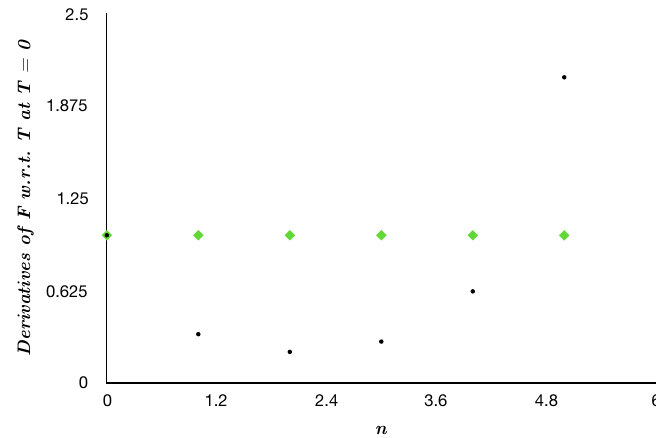
Figure 2 . Mass-independent contributions to F ( n ) ( T ) j T =0 plotted against n for the perturbation given by eq. (2.4) (black dots) and for a reference function F ref ( T ) = e T (green diamonds). Since the mass-dependent terms are all positive, this gives a lower bound on the growth of F ( T ) if the pattern displayed in the (cid:12)gure continues. This suggests that the function will grow at least at fast as e a 2 t 4